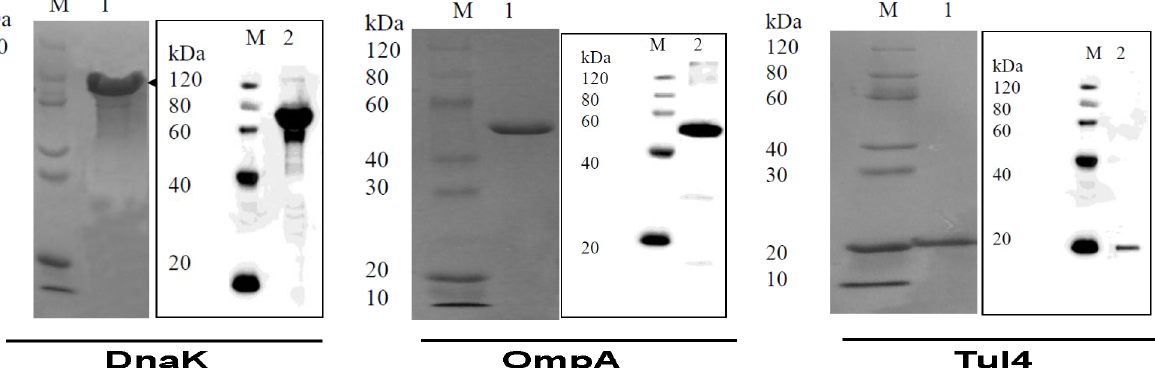
Fig 3. Expression and Purification of Recombinant DnaK, OmpA and Tul4 Proteins of F . tularensis SchuS4. Purification of recombinant OmpA, DnaK and Tul4 proteins of F . tularensis SchuS4 proteins was confirmed by SDS-PAGE and western blot analysis using anti-His antibodies.